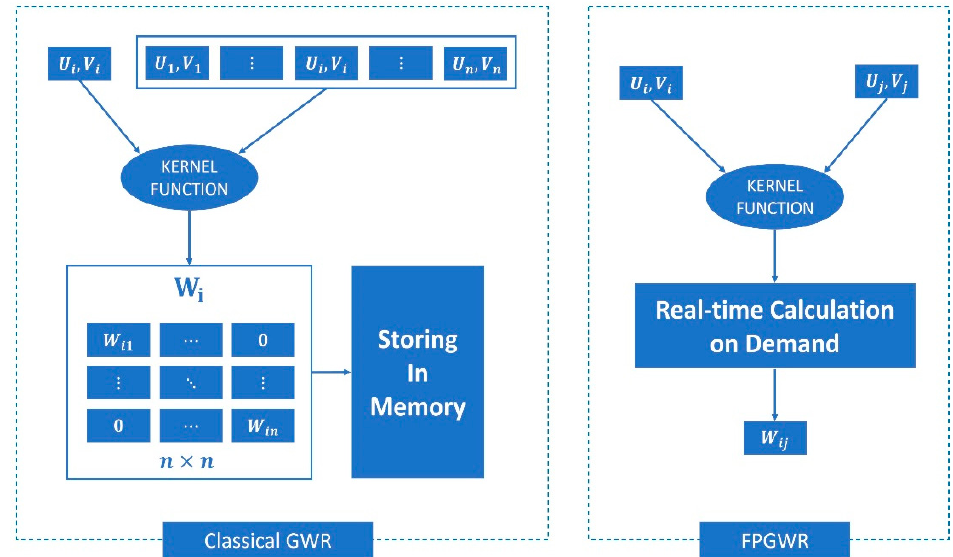
Figure 8. Di ff erent storage modes of weight matrix between classical GWR and Figure 8. Different storage modes of weight matrix between classical GWR and FPGWR.